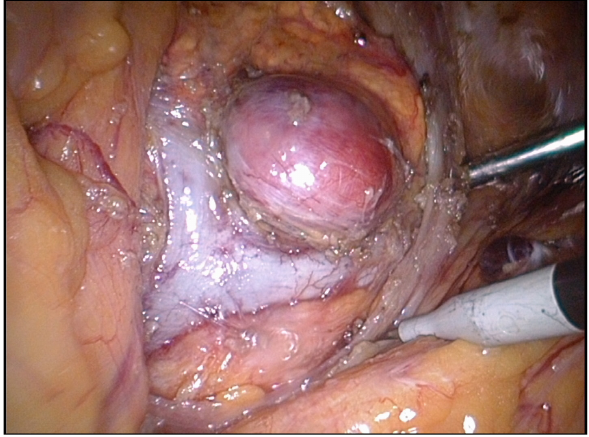
Figure 3: Left-sided adrenalectomy - the stage of cutting the adrenal